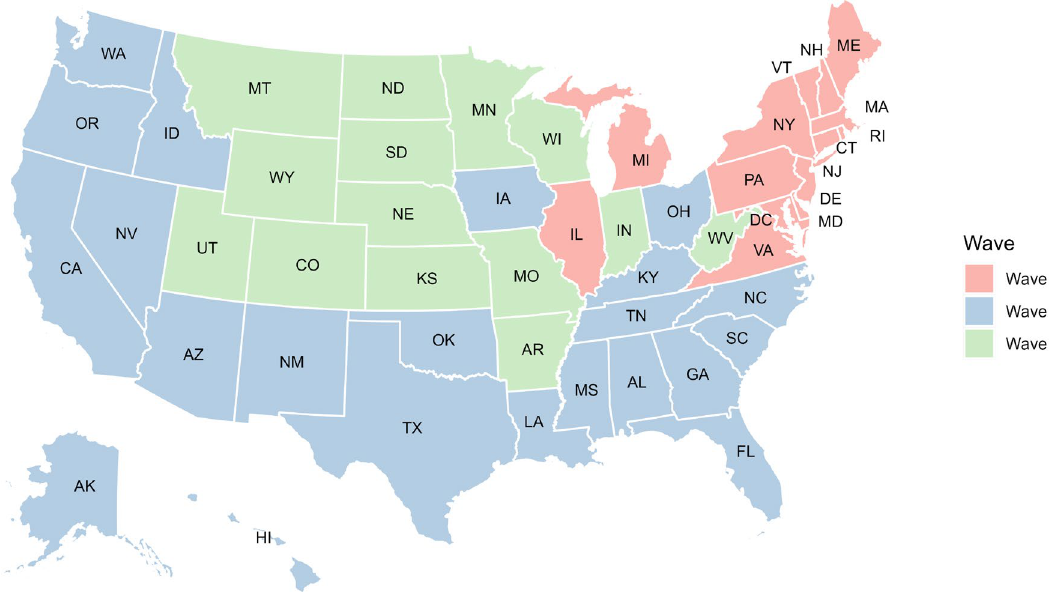
Figure 6. The waves of the pandemic across the United States. Map generated using urbnmapr 33